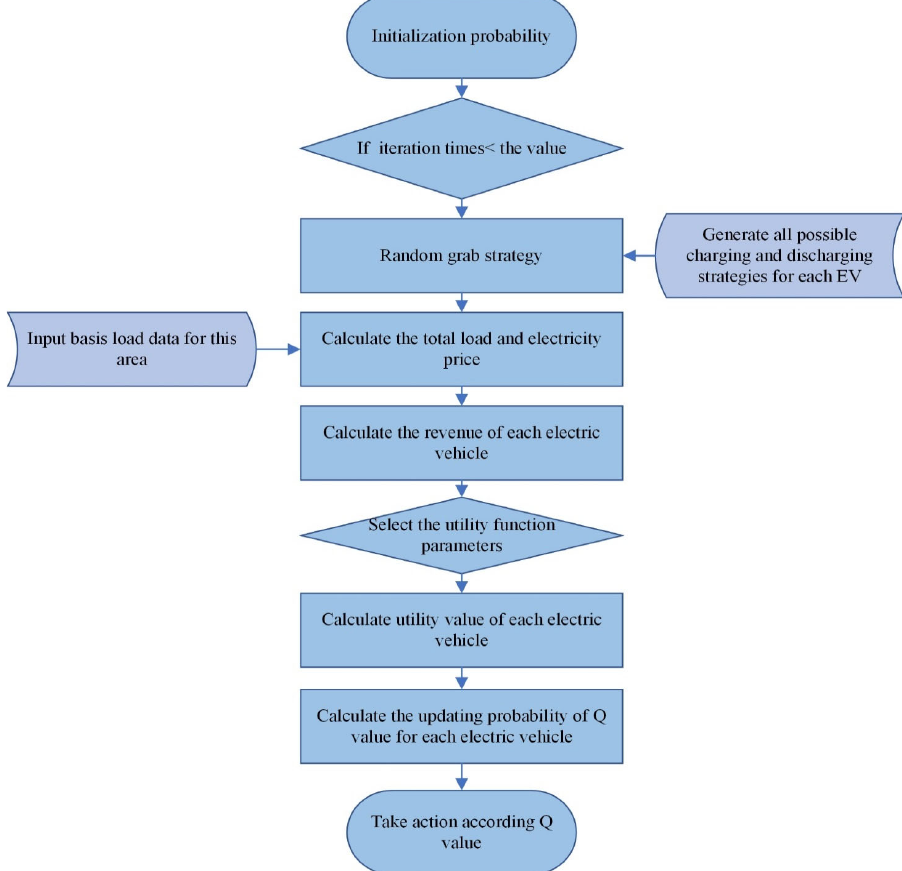
Figure 2. Variant Roth–Erev Algorithm flow chart.